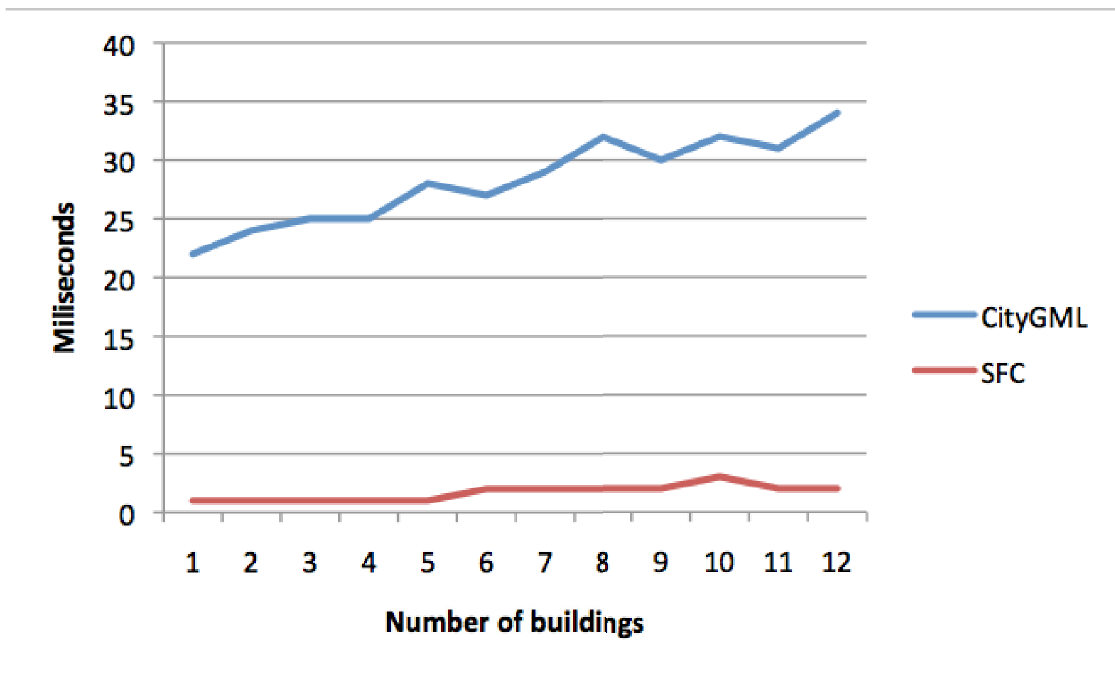
Figure 14: Data retrieval time for nearest object from target search